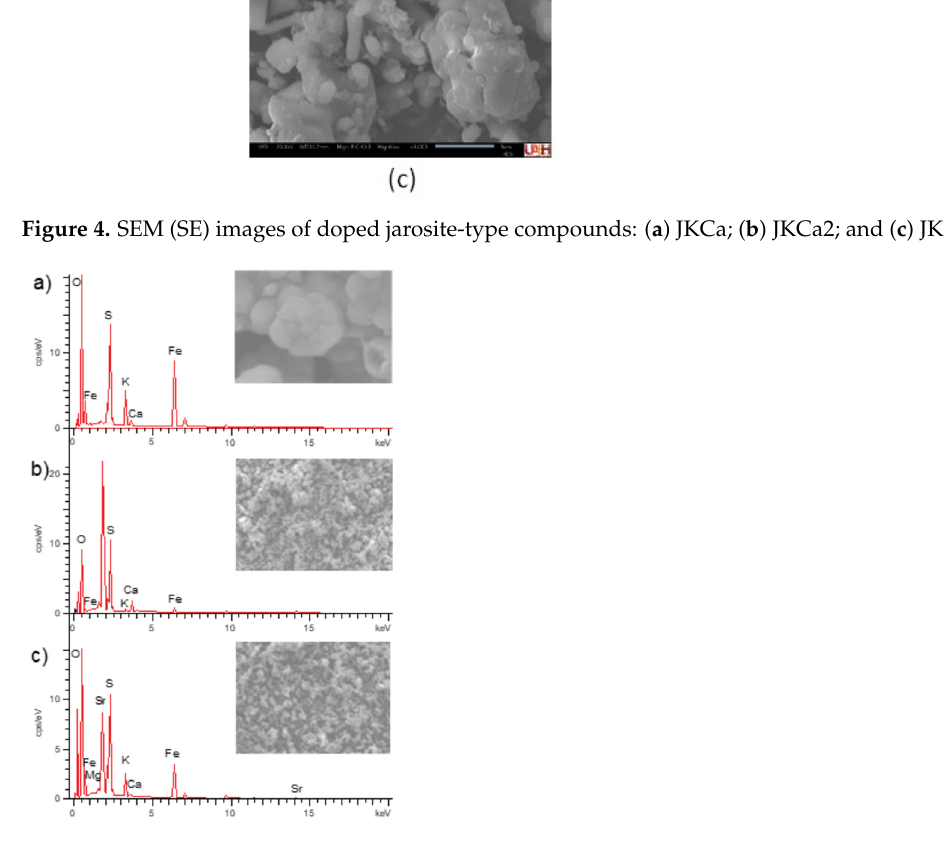
Figure 5. EDS (SEM) spectra showing the semi-quantitative chemical composition for the doped jarosite-type compounds: ( a ) JKCa; ( b ) JKCa2; and ( c ) JKAll.